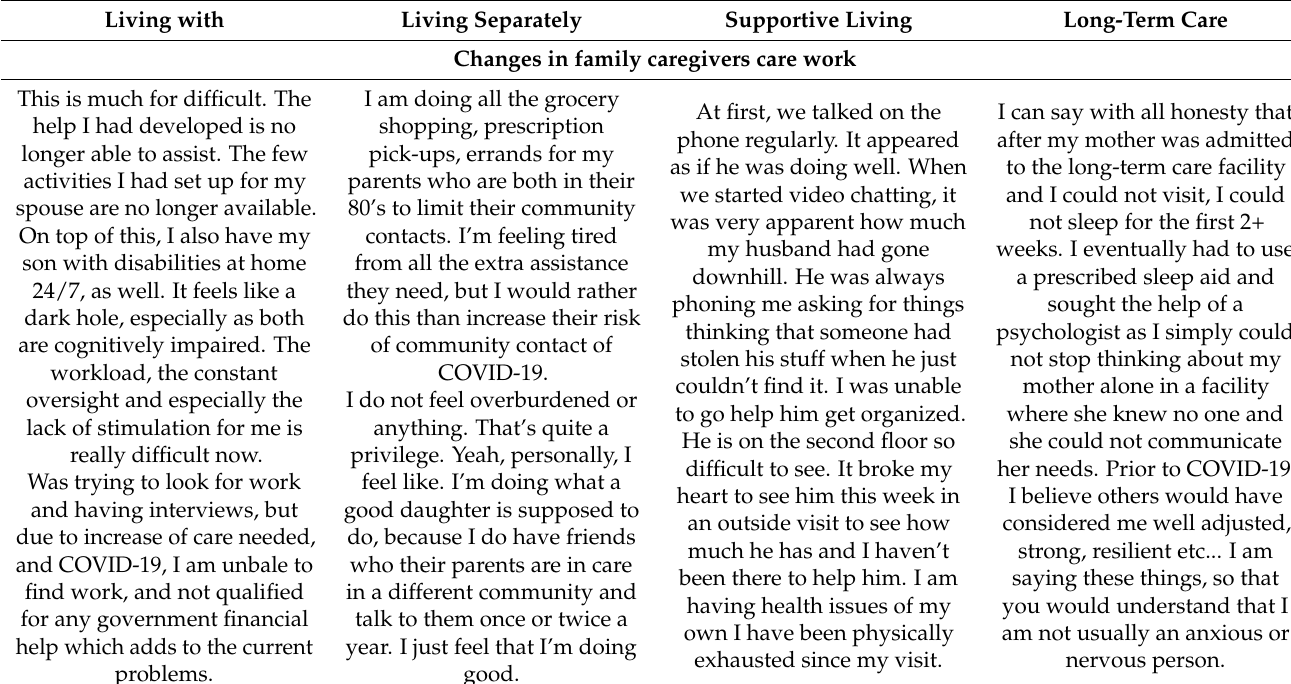
Table 4. Participants qualitative quotes by receiver’s